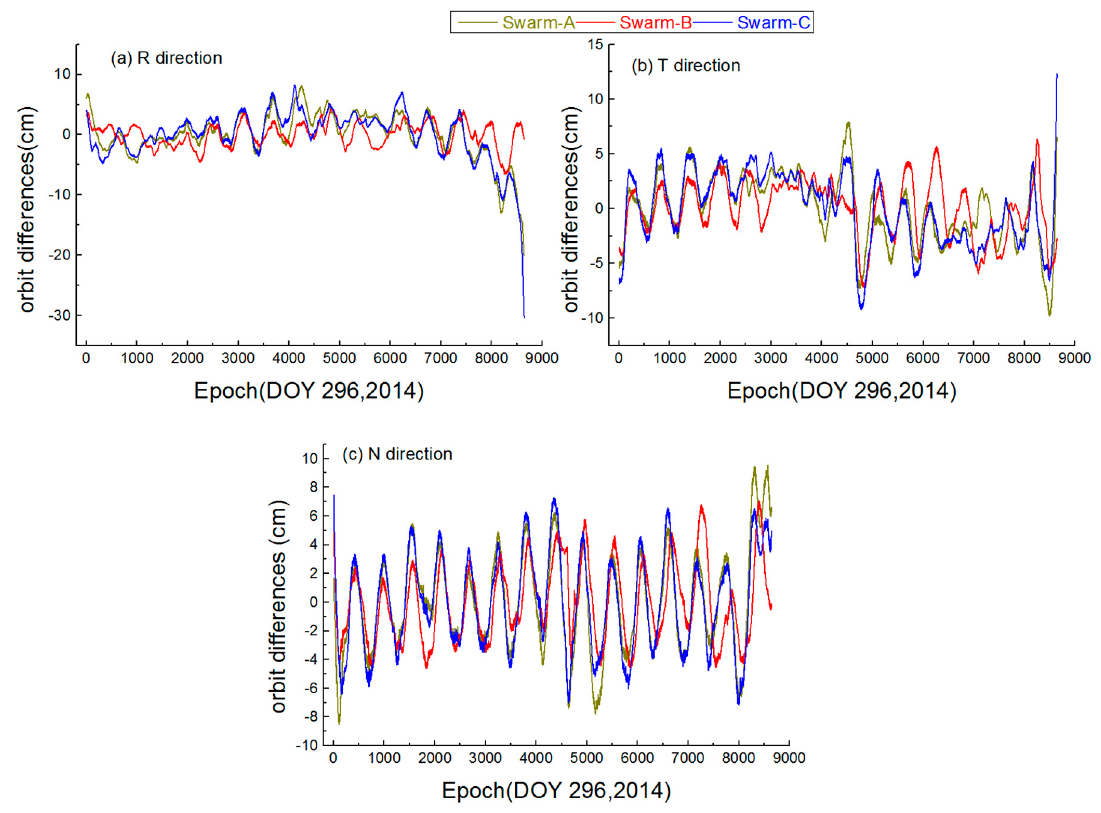
Figure 9. Orbit differences for Swarm-A, Swarm-B and Swarm-C in the R, T and N directions on the DOY 296, 2014.